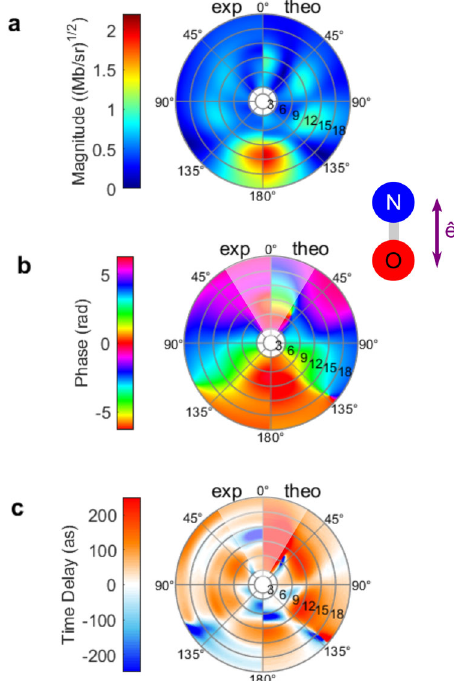
Fig. 2 Magnitude and phase of PDAs and photoionization time delays. Polar plots of a the PDA magnitudes, b PDA phases, and c photoionization time delays. The left (right) half of each map corresponds to the experimental (computed) data. The radial distance from the center of the maps gives the photoelectron kinetic energy E in eV. The polar angle θ k is relative to the NO molecular axis, with ( θ k ¼ 0 (cid:3) ) corresponding to the direction of the N atom. In this and all subsequent fi gures, magnitudes have ffiffiffiffiffiffiffiffiffiffiffiffiffiffiffiffiffi p been multiplied by 4 π 2 h ν = c so that their absolute squares yield the differential cross-section in Mbarn/steradian. See text and Fig. S4 (Supplementary Note 7) for corresponding